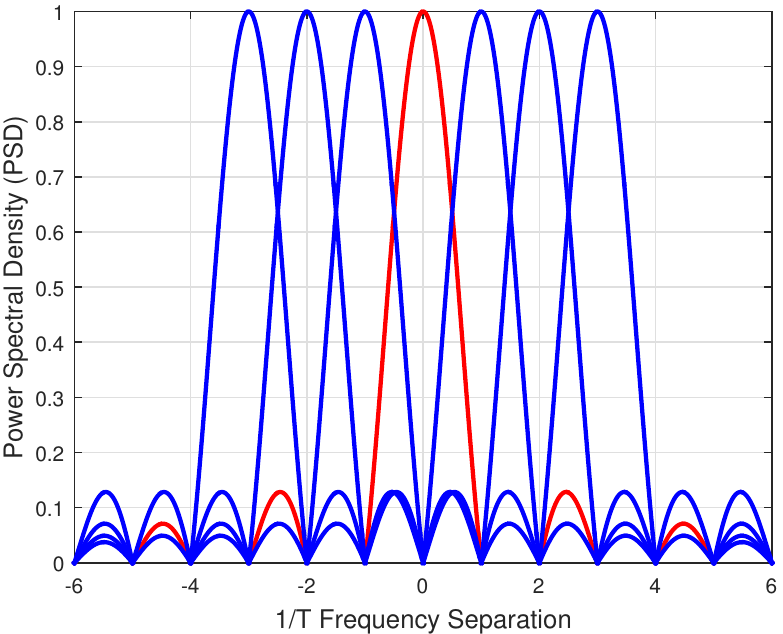
Figure 1. Spectrum of an OFDM signal with N subcarriers. Subcarriers of M -ary QAM OFDM or M-ary PSK-OFDM with spacing of 1/ T .